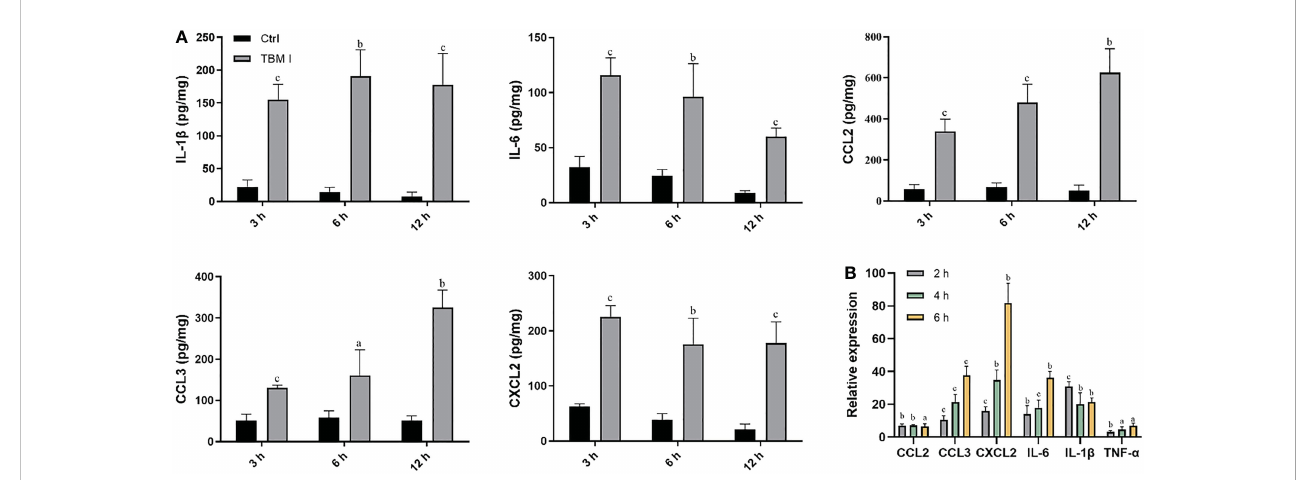
FIGURE 4 TBM I elicited cytokine and chemokine expression at the injection site. Mice were injected i.m. with TBM I and mock contralateral muscle received PBS. (A) The levels of cytokines and chemokines in quadriceps muscles at 3, 6, and 12 hpi by ELISA. (B) The gene expression levels of cytokines and chemokines in quadriceps muscles at 2, 4, and 6 hpi using RT-qPCR. The data are presented as mean ± SD ( n = 5). a P < 0.05, b P < 0.01, and c P < 0.001 vs OVA.